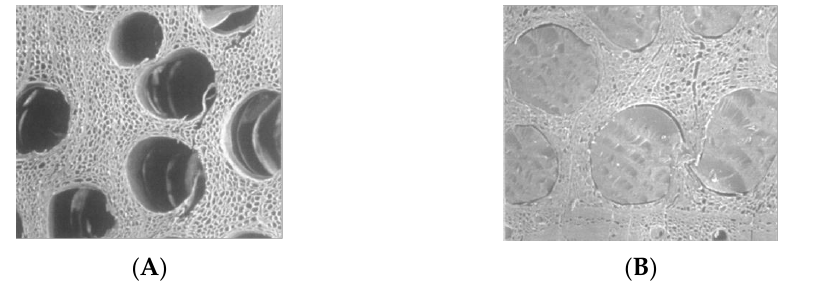
Figure 11. Scanning micrograph of solid wood before polymer impregnation with open lumens ( A ) and after polymer impregnation with filled lumens ( B ).